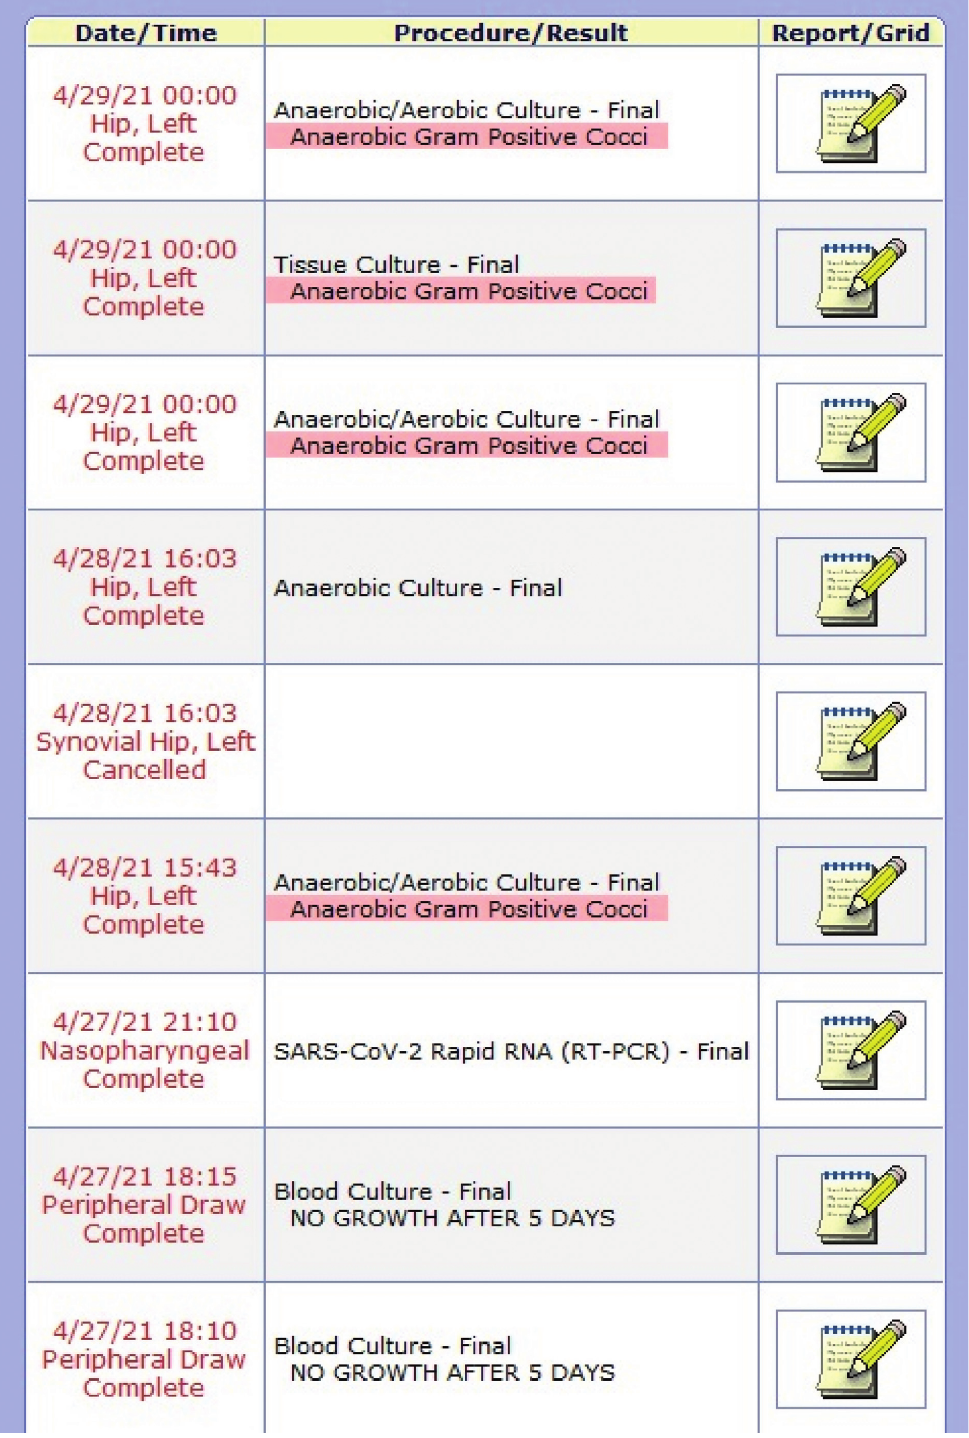
Figure 1: Compiled view of culture